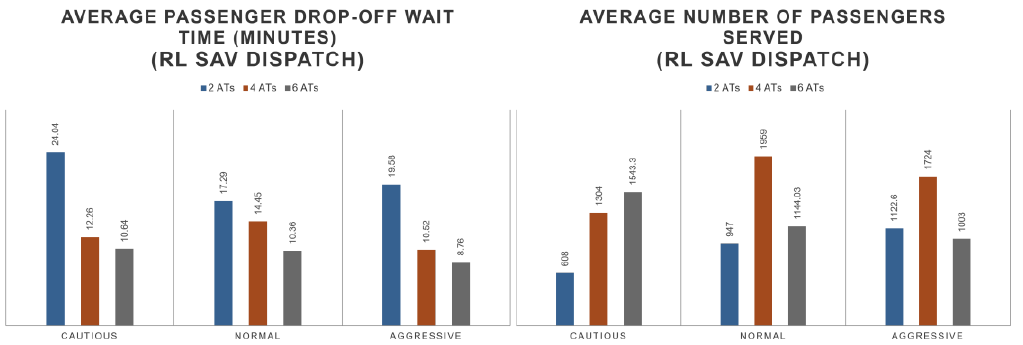
Figure 22. More stats on SAV dispatcher.